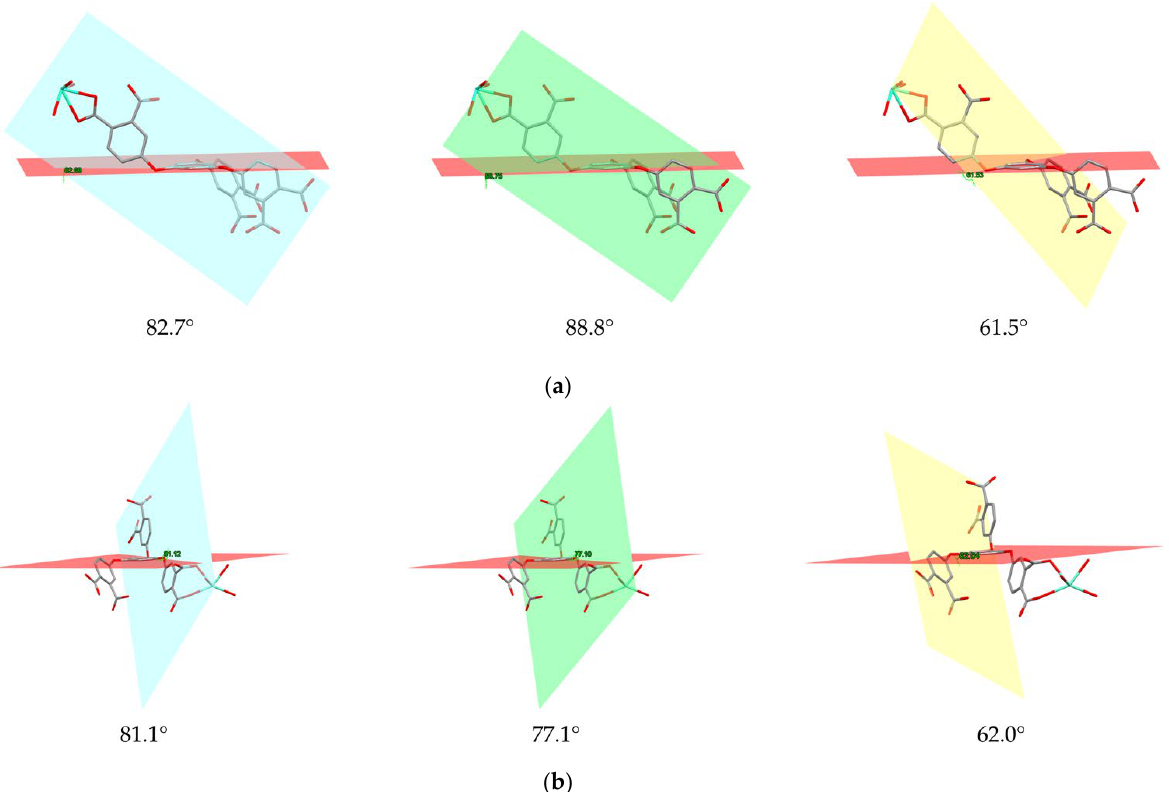
Figure 3. Dihedral angles between the central benzene ring and the phenoxy rings in H 3 L 3- ligand in the structure of the compounds 1 ( a ) and 2 ( b ). the structure of the compounds 1 ( a ) and 2 ( b